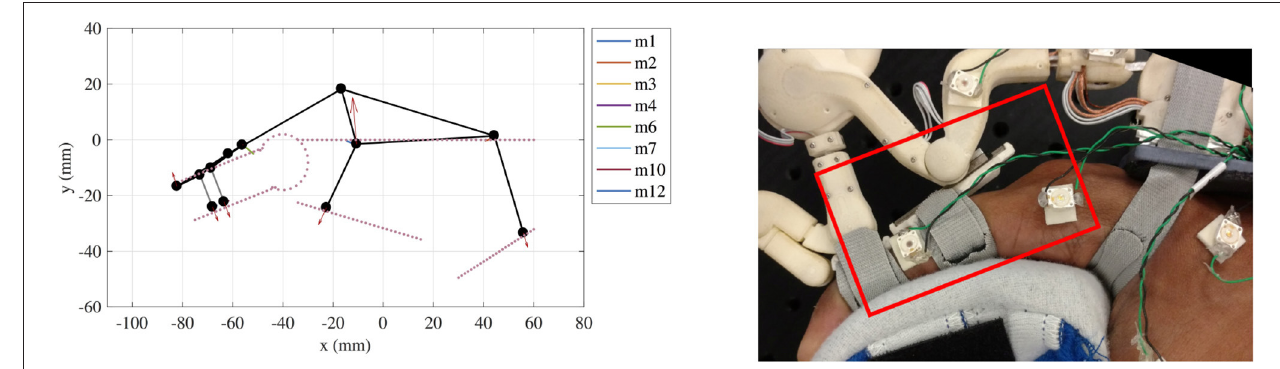
FIGURE 12 | (Left) An example of simulated prediction of liftoff at the proximal phalanx attachment. (Right) The physical manifestation of the same during experimental characterization.